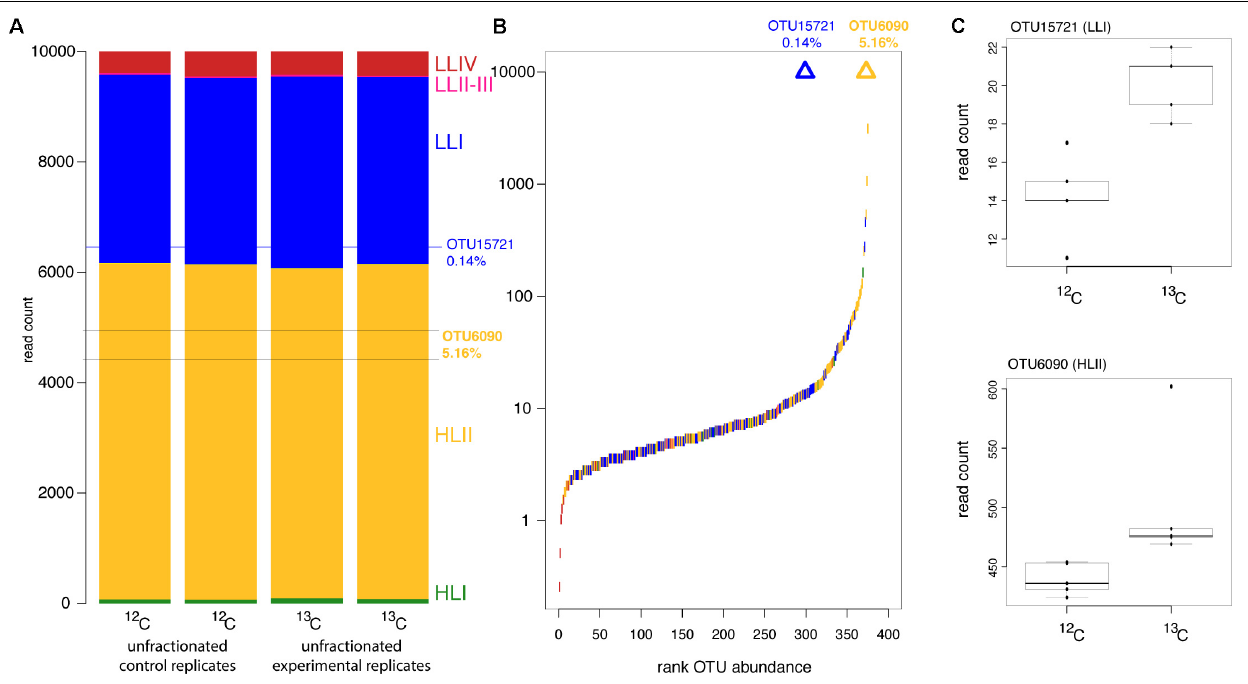
FIGURE 2 | Prochlorococcus ecotype and OTU abundance during the DNA-SIP incubation experiment. (A) Ecotype composition of replicate unfractionated DNA samples with the proportion of reads made up by responder OTUs marked with horizontal lines. (B) Rank abundance of OTUs in unfractionated samples with responder OTUs marked by triangles aligned to their rank abundance. Colors indicate the ecotype identity of each OTU according to colors in (A) . (C) Boxplots of read counts from replicate samples from 12 C control and 13 C experimental heavy fractions for the responder